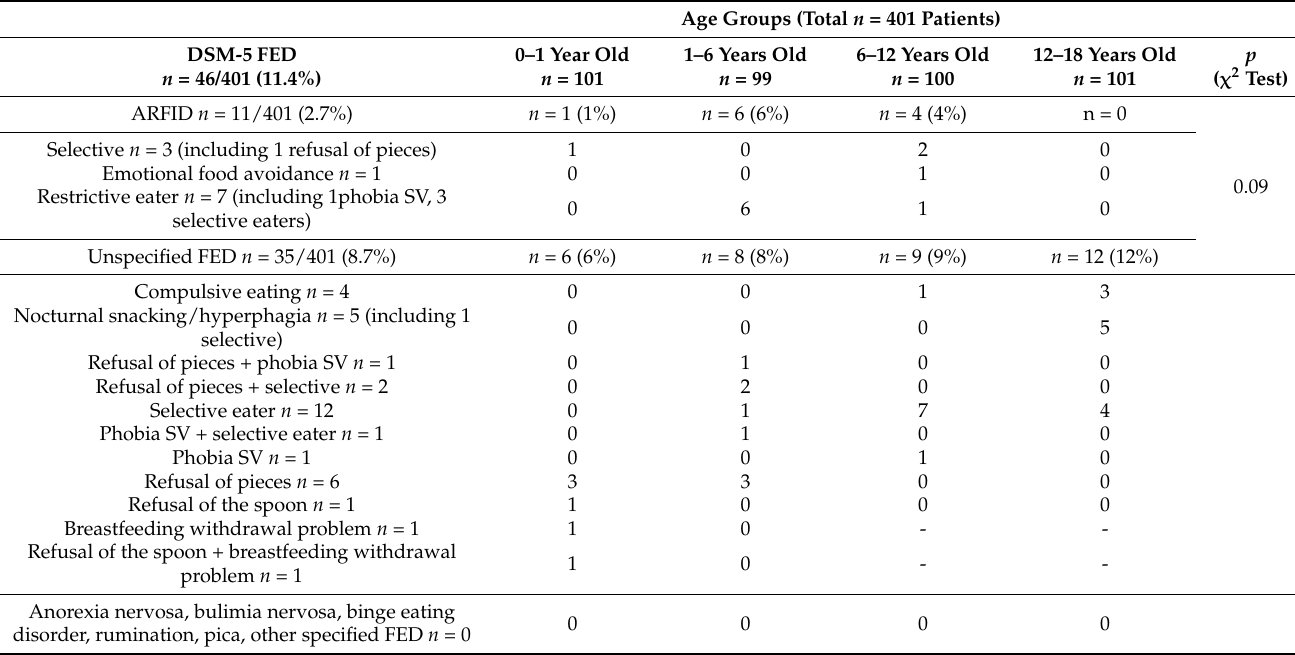
Table 3. Prevalence of patients with feeding and eating disorders (FED) according to the DSM-5 classification. Age Groups (Total n = 401